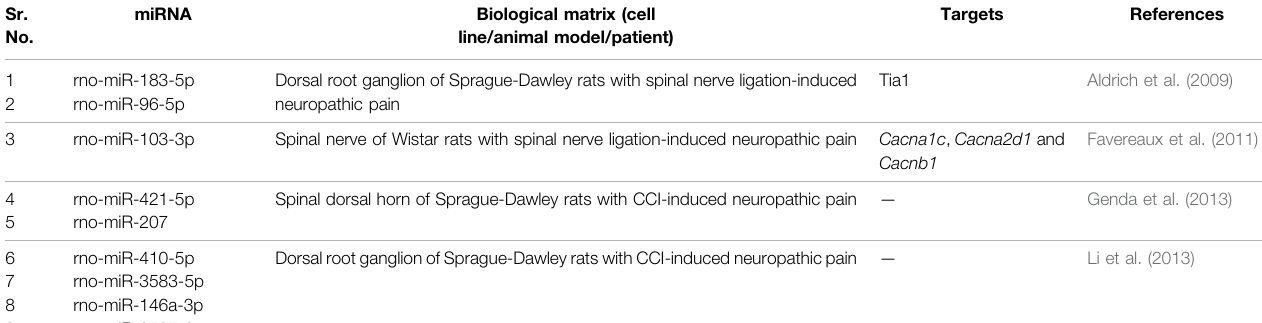
line/animal model/patient)